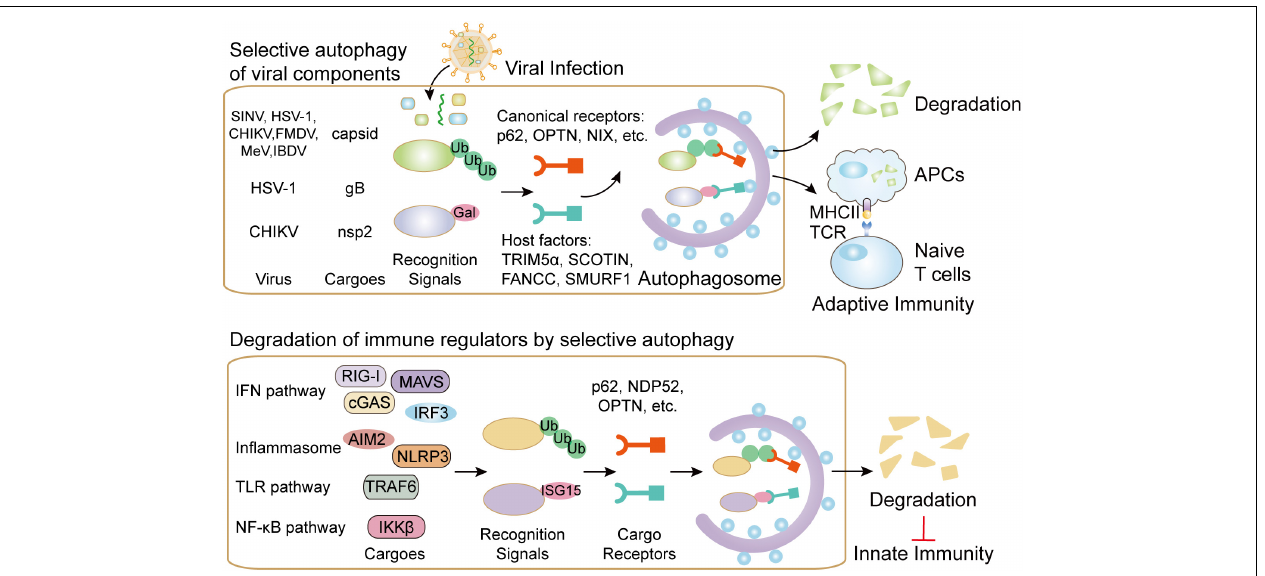
FIGURE 1 | The functions of selective autophagy during viral infection. Selective autophagy targets invading viruses by directly delivering them to autophagosomes for degradation. Several canonical autophagy cargo receptors such as p62 could bind to ubiquitin-coated viral particles or components. Moreover, several host factors, including TRIM5 α , SCOTIN, FANCC, and SMURF1, are also reported to assist the transportation of viral components to autophagosomes. In addition to directly targeting viral particles for degradation, selective autophagy also contributes to viral presentation on MHC-II and MHC-I in APCs, thus initiating antiviral adaptive immunity. On the contrary, cargo receptors in selective autophagy pathway could also control autophagic degradation of key molecules in IFN, inflammasome, TLR and NF- κ B pathway in order to reduce excessive innate immunity during viral